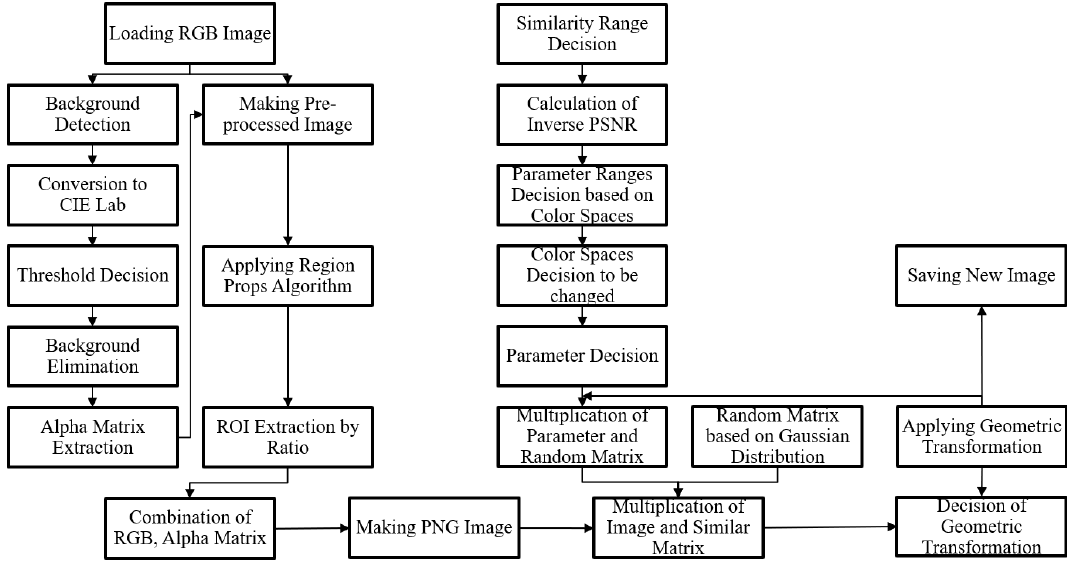
Figure 2. Overview of the proposed method.